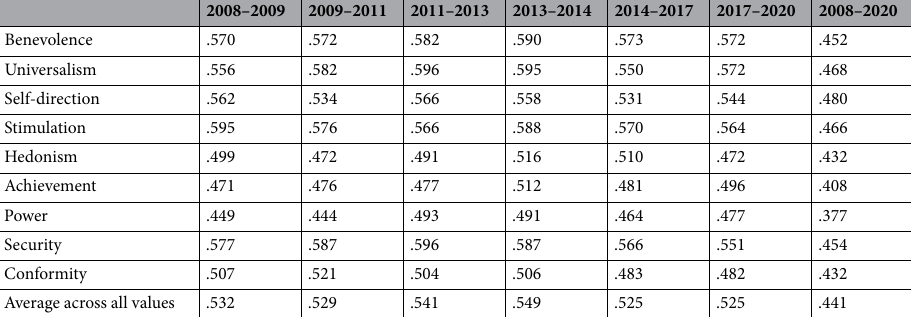
Table 2. Rank-order stability (Spearman rank-order correlations) in full sample of each human value over time between pairs of waves. Columns indicate Spearman rank-order correlation coefficient for each value- type between 2 waves: Time between waves varies from 1 to 3 years. Last column indicates coefficient between first and last wave (12-year period). All correlations are significant p < .01.